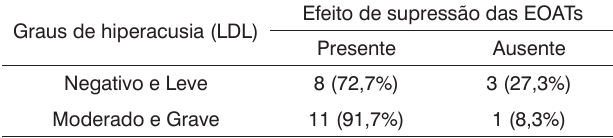
Tabela 6. Graus de hiperacusia segundo o LDL e ocorrência do efeito de supressão das EOATs na orelha direita.